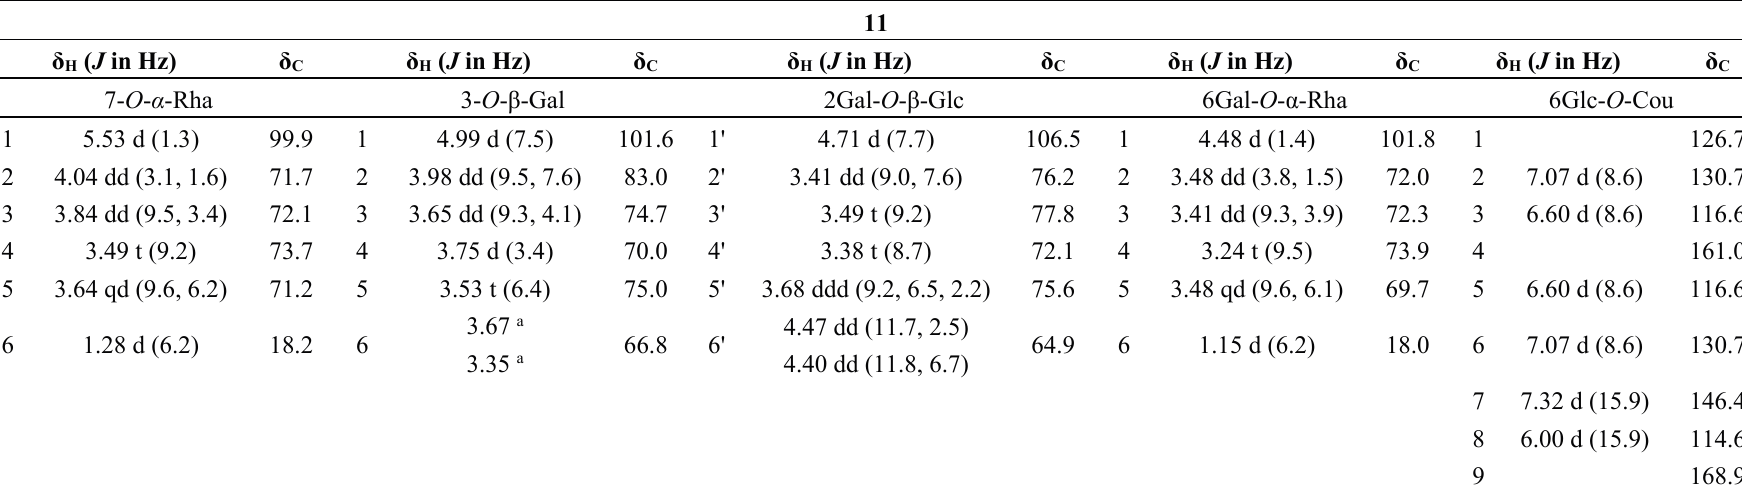
Table 5. NMR spectroscopic data (methanol- d 4 , 500 MHz) for the sugar and phenolic acid units of the compound 11